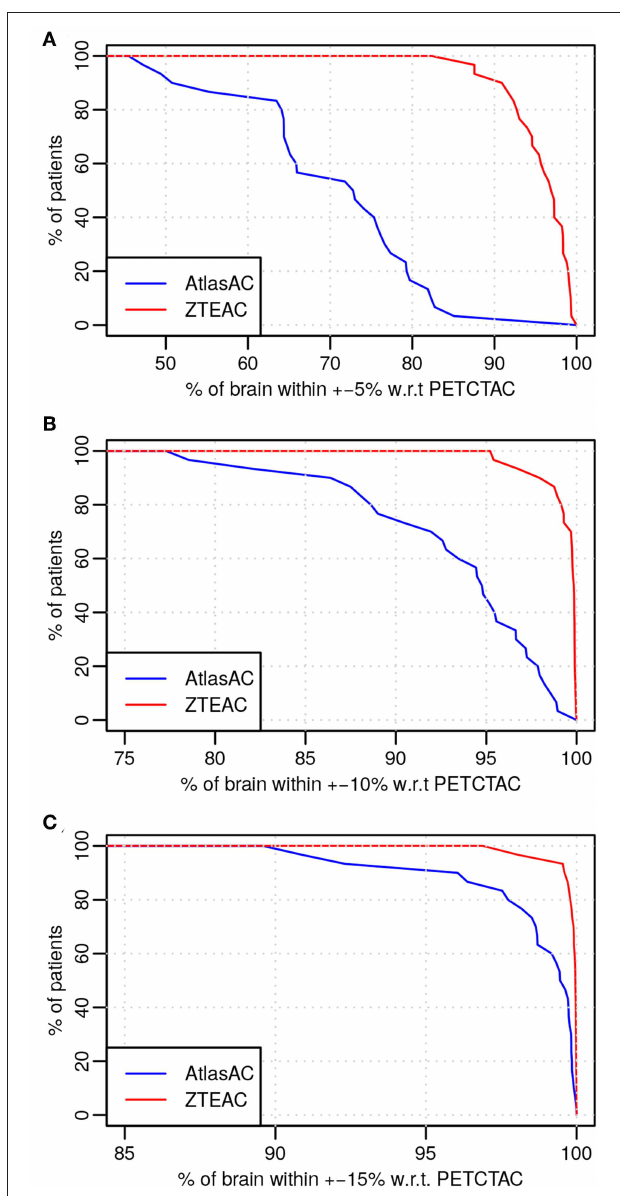
FIGURE 6 | Outlier analysis [17] of the 30 static acquisitions for PET ZTEAC (red) and PET AtlasAC (blue) for the bias thresholds of (A) 5%, (B) 10%, and (C) 15%. Note the different scale on the